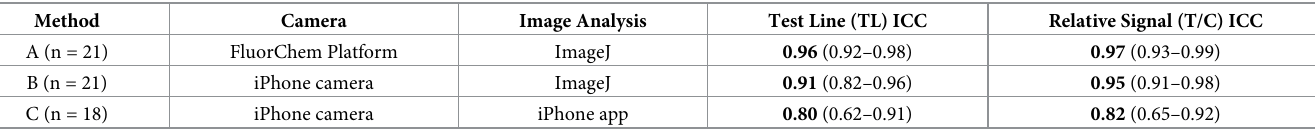
Table 1. Comparison of single measure intraclass correlations (ICC) in a two-way mixed-effects model for consistency of agreement using different combinations of imaging devices and image analysis tools (method A, B, C) for the same set of LFA strips. For each method, the ICC is followed by the 95 percent confidence interval enclosed in